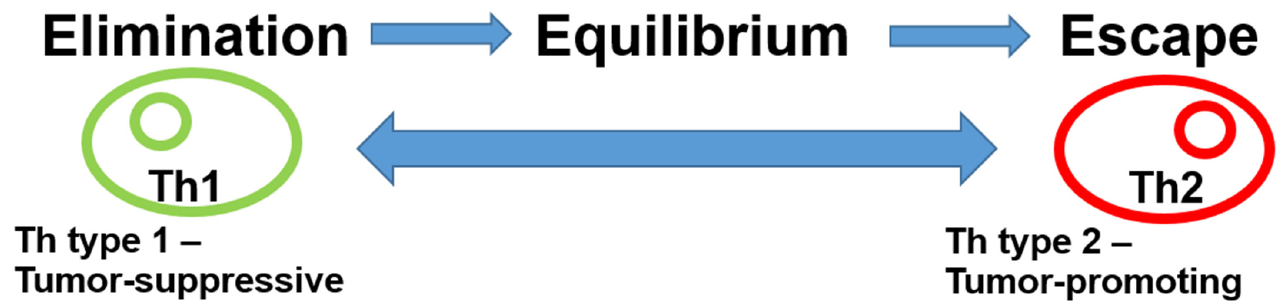
Figure 1. Immunoediting in breast cancer. Cancer immunoediting has dual host-protecting and tumor-sculpting actions of the immune system that not only prevent but also shape neoplastic disease. Cytokines determine T-cell polarization. Th1 and Th2 cells are characterized by their mutually exclusive expression patterns of cytokines. Th1 cells produce IFN- γ , whereas Th2 cells produce IL-4, IL-5, and IL-13. The presence of IL-12 and/or interferon- γ drives previously uncommitted T cells to become polarized to produce T1 cytokines, while IL-4 drives them to become polarized to secrete T2 cytokines. This, in turn, leads to either a tumor-suppressive or a tumor-promoting microenvironment. Abbreviations: Th, T helper cells.